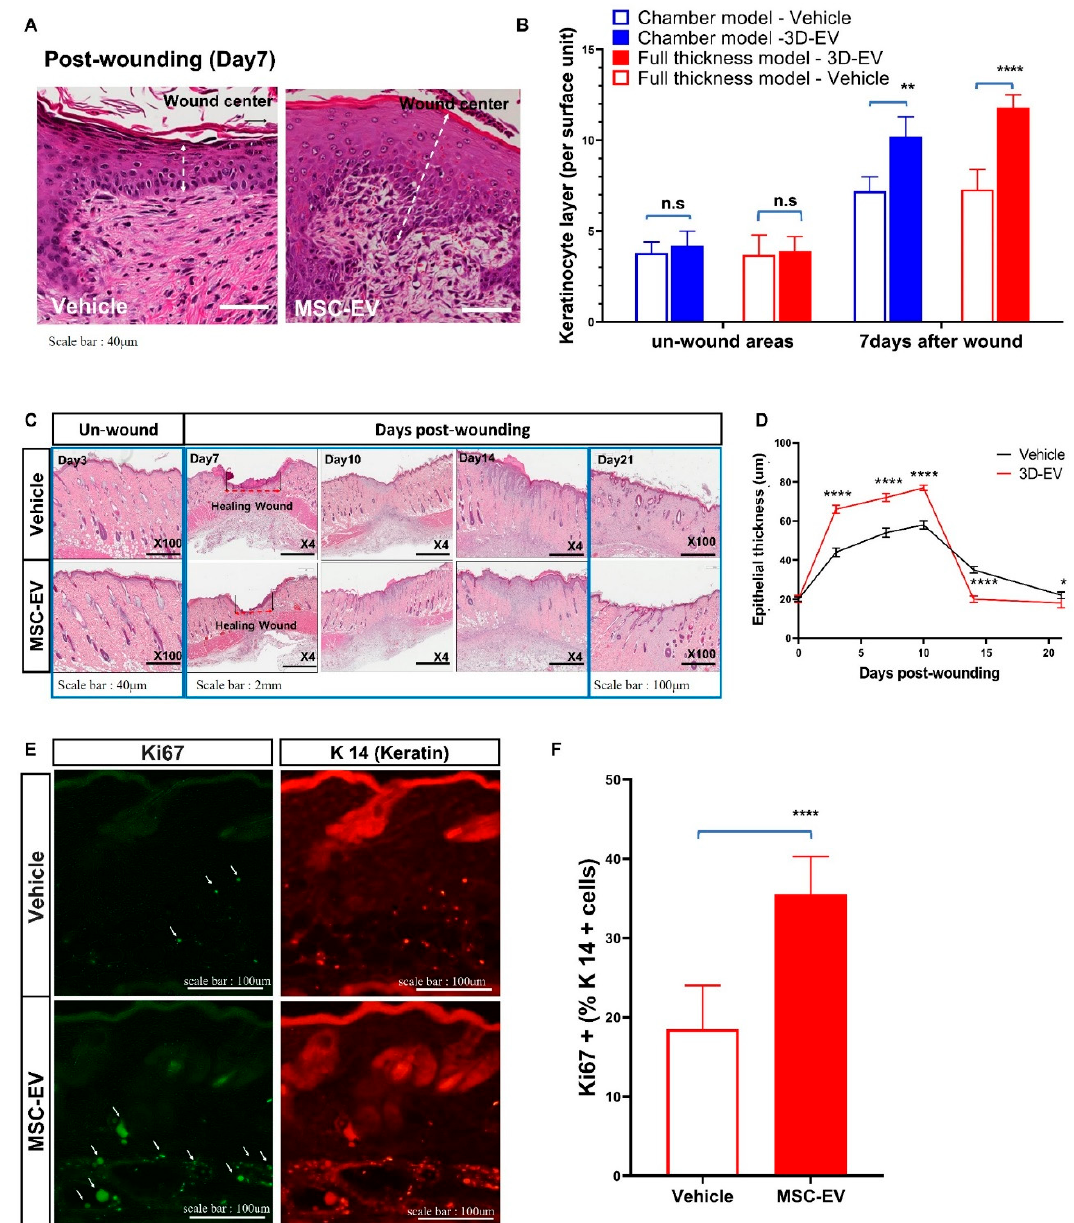
Figure 3. EVs promote the proliferation and migration of keratinocytes during the initial epidermal hypertrophy process. ( A , B ) Mesenchymal stem cell (MSC)-EVs accelerate wound healing with individually migrating keratinocytes in a mouse chamber model. Scale bar: 40 μ m. ( C ) H&E-stained histopathological whole-slide images of full-thickness wounds at 3, 7, 10, 14, and 21 d post-wounding. (Unwounded, day 3, magnification, 100×, scale bar, 100 μ m), (days post-wounding, from day 7 to 14, magnification, 4×, scale bar, 2 mm), (days post-wounding, from day 21, magnification, 100×, scale bar, 100 μ m). ( D ) Serial changes in epidermal thickness were measured and compared between the EV and control groups. ( E ) Immunohistochemical image of the epidermis and ( F ) measurement of epidermal thickness 7 d after wound induction. White arrows indicate Ki67+/ keratinocyte cells. Scale bar: 100 m. Data represent the mean ± SD. ns: p > 0.05, not significant, **** p < 0.0001, ** p < 0.01, and * p < 0.05.